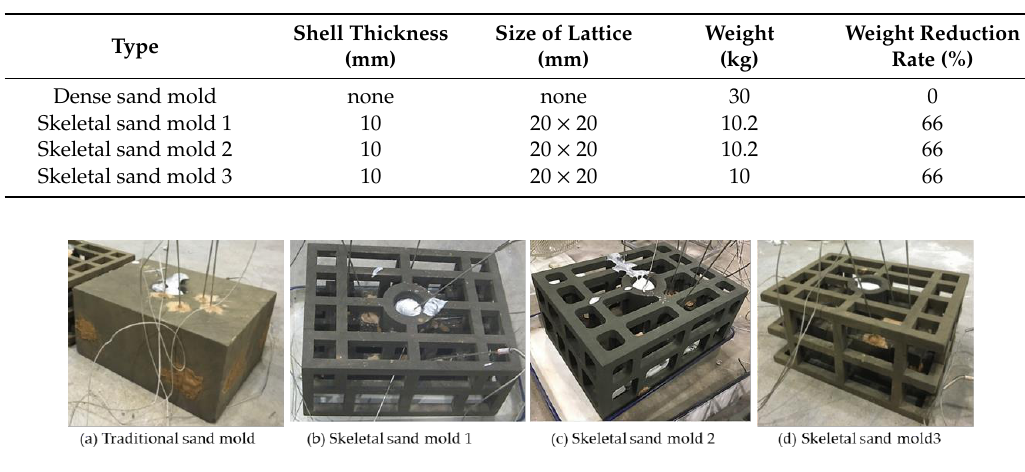
Figure 28 . Comparison of the simulated and experimental cooling curves of thick (a) and thin (b) bars of the specimen The surface temperature of the sand mold was monitored using the infrared imaging camera Flir T250. A comparison is shown in Figure 29. The surface temperature of the sand mold was below 37 ℃ , and only a small area (where holes were drilled for the cleaning of unbonded sand in the mold and then sealed with clay) reached 97 ℃ . Thus, the heat released from the casting was mainly absorbed by the sand mold block, with less heat dissipation to the environment. The highest temperature zone in the middle was in the riser. (a) (b) Figure 29. Infrared imaging of the traditional sand mold surface temperature: (a) 2000 s and (b) 5600 s. On the other hand, the surface temperature of the skeletal sand mold reached above 400 ℃ 250 s after pouring. Then, it decreased slightly to 320 ℃ 700 s later. Even after 2000 s, the shell temperature was still approximately 140 ℃ . The temperature of the shell surface was relatively uniform. The highest temperature was at the shell wrapping the thick bar. The lattice structure was